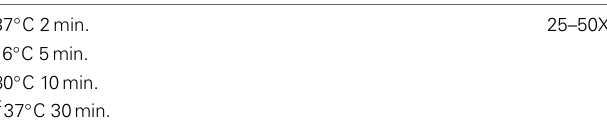
Table 2 | PCR cycling parameters for Golden Gate Cloning reaction where there are no internal BsaI/SapI sites within the insert fragment(s).